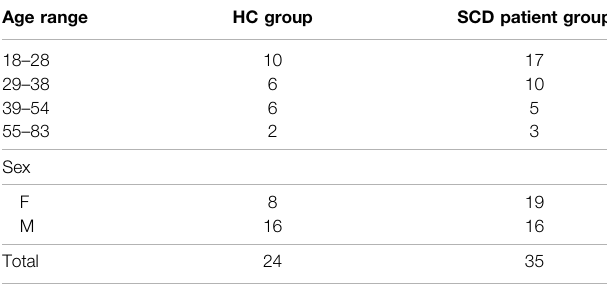
TABLE 1 | Summary of subject